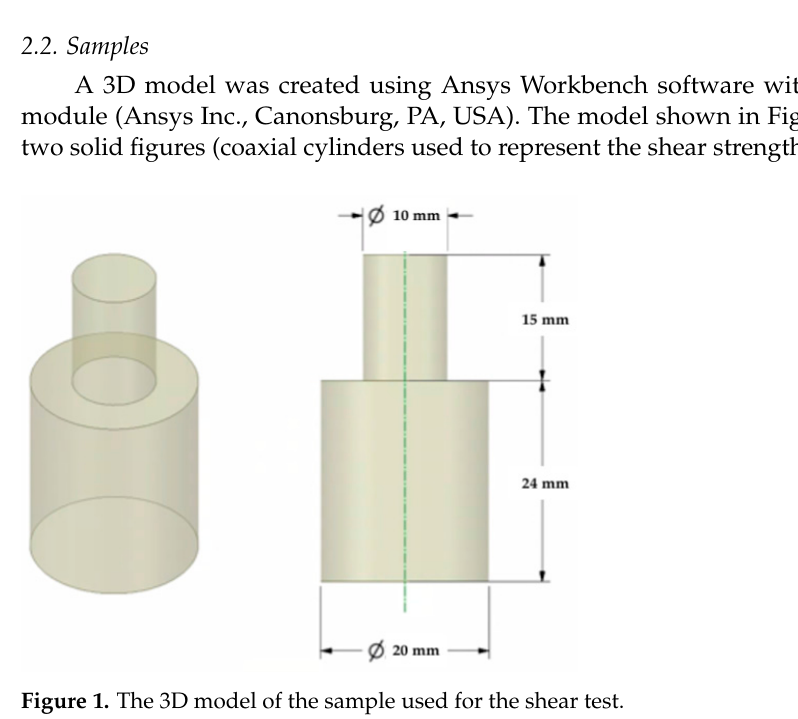
Table 1. Mechanical properties of PLA and TPU, referring to the technical data sheet [44,45].